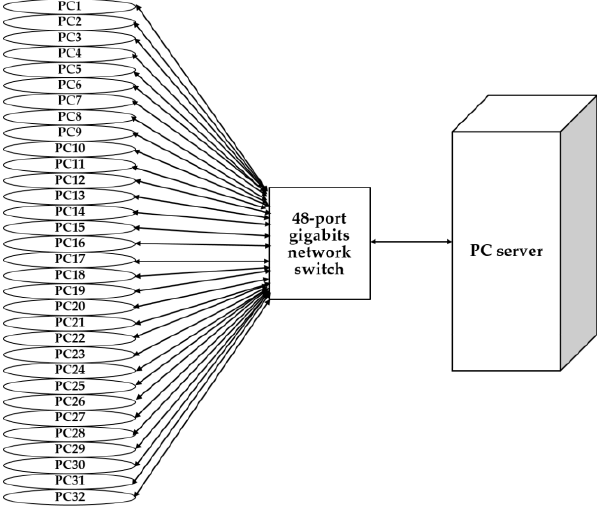
Figure 9. Configuration of experiments.